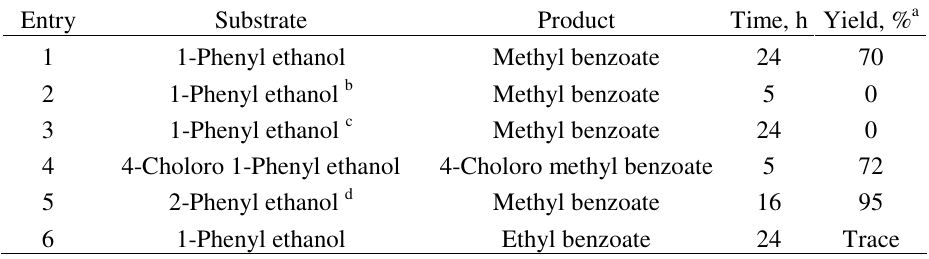
Table1. Oxidation of some alcohols to esters in different condition